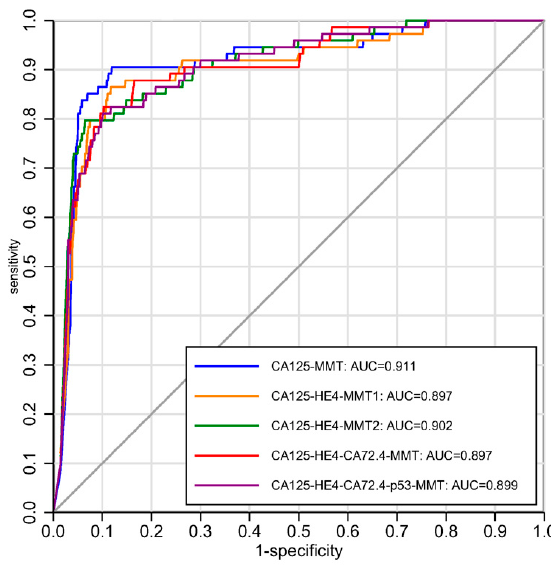
Figure 1. ROC curves with the AUC for each of the longitudinal algorithms.